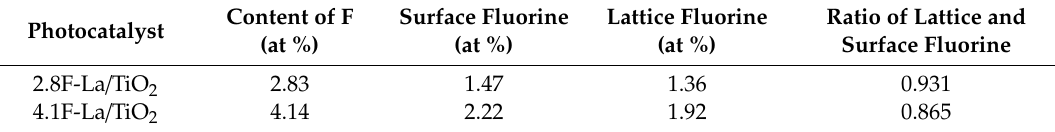
Table 4. Surface concentration of surface fluorine and lattice fluorine determined by XPS.